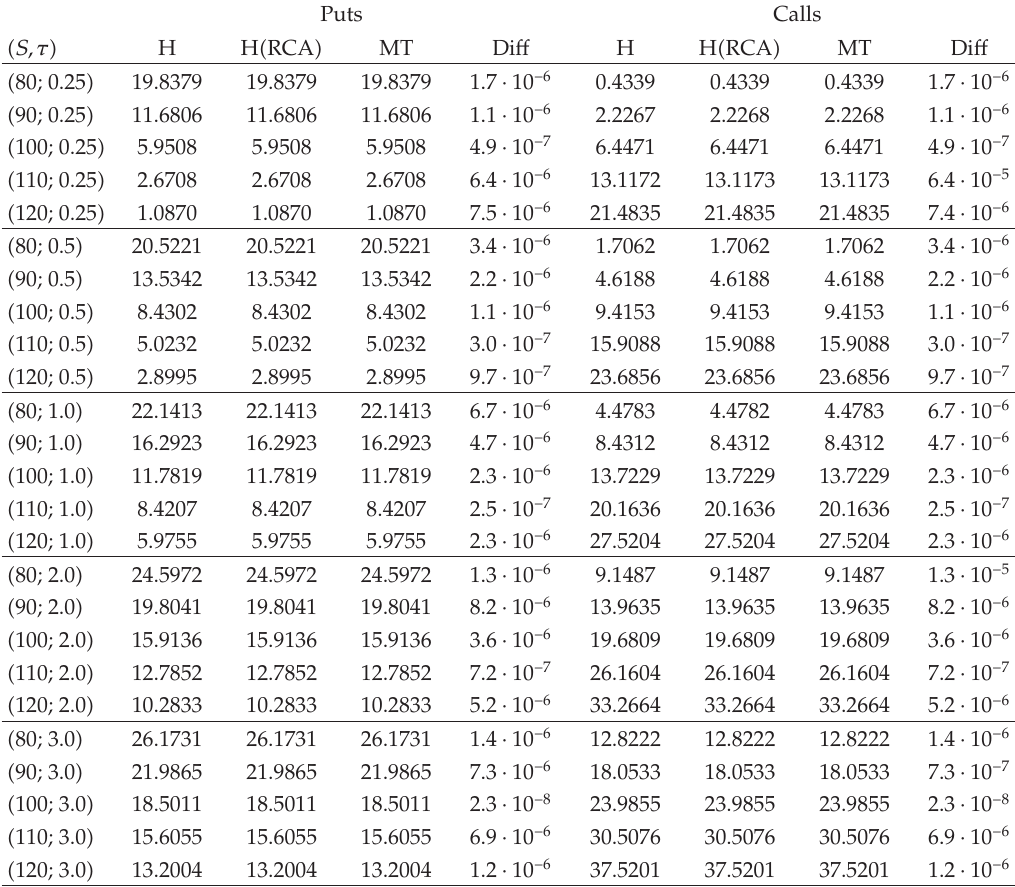
Table 1: European option prices in Heston’s stochastic volatility model for di ff erent asset prices S and maturities τ . Fixed parameters are X (cid:8) 100, r (cid:8) 0 . 04, q (cid:8) 0 . 02, V (cid:8) 0 . 09, κ (cid:8) 3, θ (cid:8) 0 . 12, ξ (cid:8) 0 . 2, ρ (cid:8) − 0 . 5, and c (cid:8)